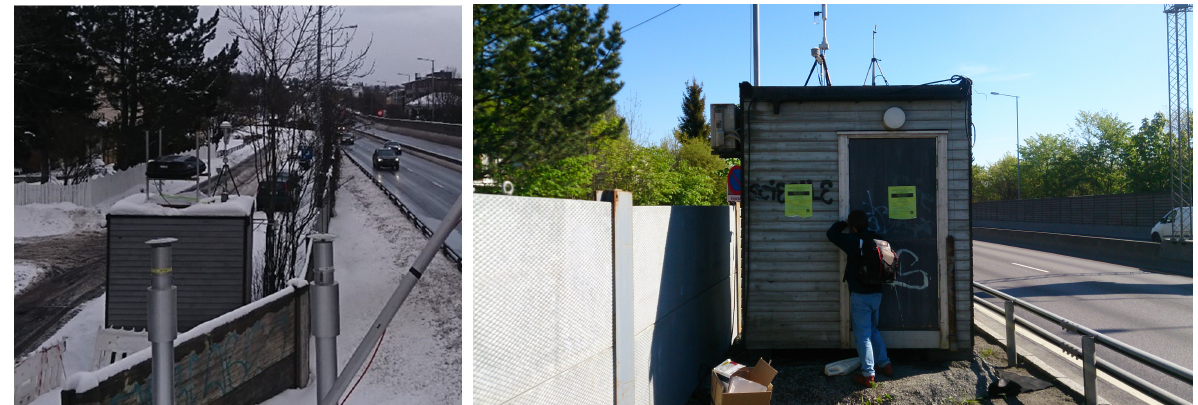
Figure 4. Permanent location of station 504 at Smestad ( left ). Temporary location of station 504 from 21 May 2015 to 8 February 2017 ( right